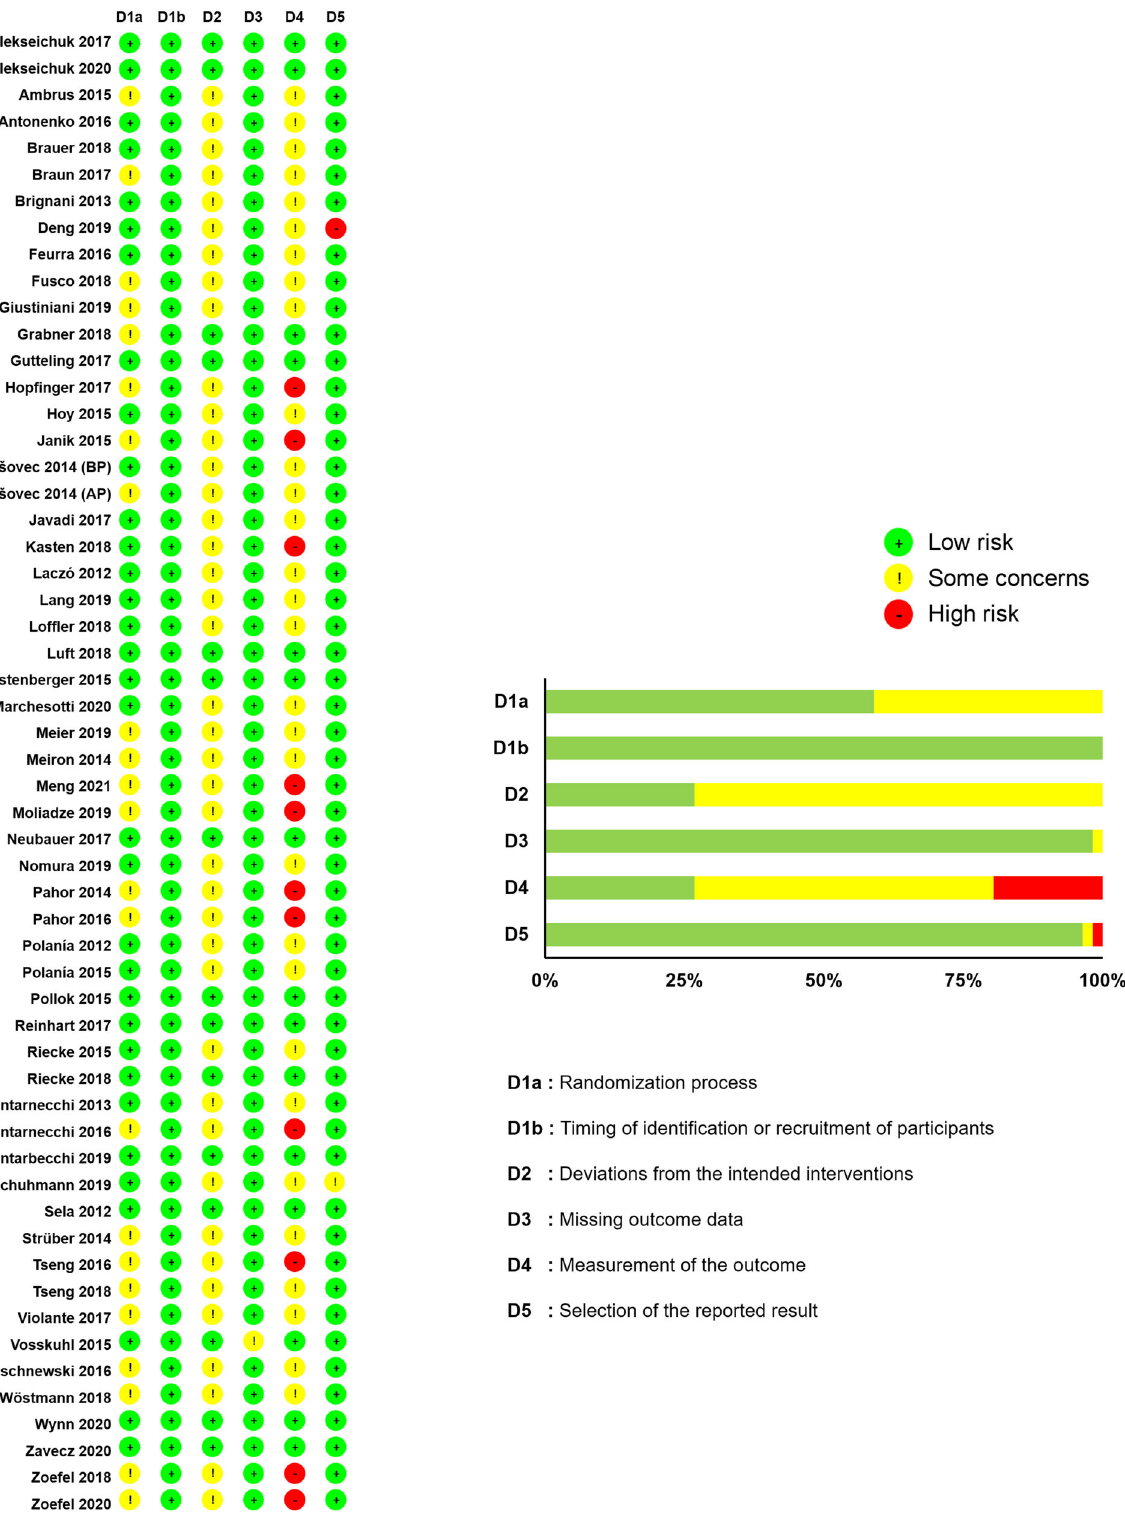
Fig. 2 Methodological quality assessment. The Cochrane risk of bias assessment reveals potential methodological concerns. For the comparisons of each frequency band of online-tACS protocols, the fourth moderator variable analysis investigated different changes in cognitive performances based on cognitive domains, respectively. The analysis revealed signi fi cant positive effects for the following conditions: (a) 17 executive function / complex